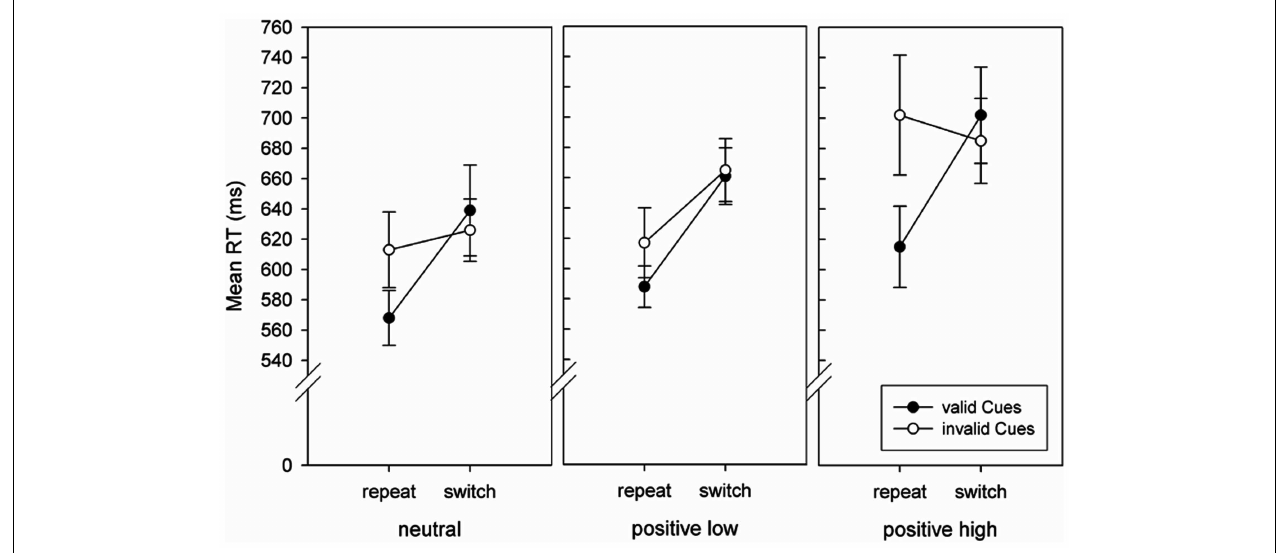
FIGURE 3 | Mean RTs (in ms) in the first task switching block with informative task cues of Experiment 3 as a function ofAffect group,Trial type, and Cue validity. Error bars represent 1 standard error of the mean.